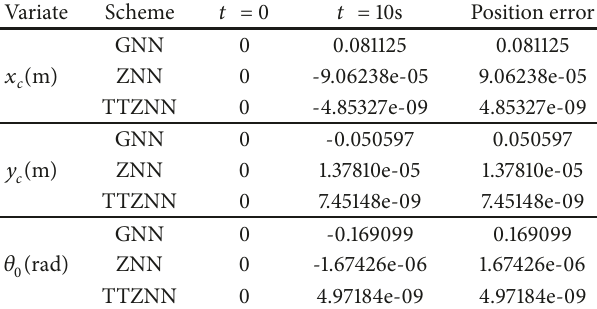
Table 2: Position profiles of the mobile base when its end-effector tracks a circle path using different neural